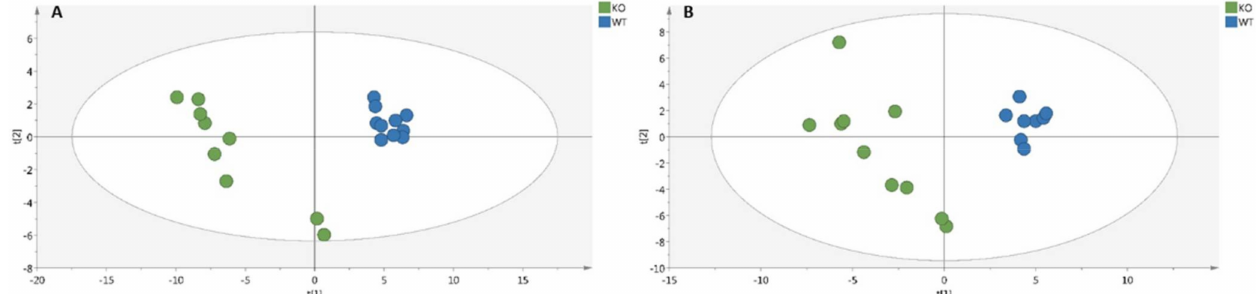
Figure 1. PLS-DA score plot analysis of serum ( A ) and soleus ( B ) samples in Klf10 KO and WT by UHPLC-MS. ( A ) Metabolome score plots of PLS-DA on serum (WT in blue circle, n = 10 and Klf10 KO green circle, n = 9). The performance characteristics of the model using 96 variables, are R 2 Y = 0.974, Q 2 = 0.87 and CV-ANOVA = 4.42 × 10 − 6 . ( B ) Metabolome score plots of PLS-DA on soleus (WT in blue circle, n = 9 and Klf10 KO in green circle, n = 10). The performance characteristics of the model using 88 variables, are R 2 Y = 0.93, Q 2 = 0.86 and CV-ANOVA = 5.46 × 10 − 7